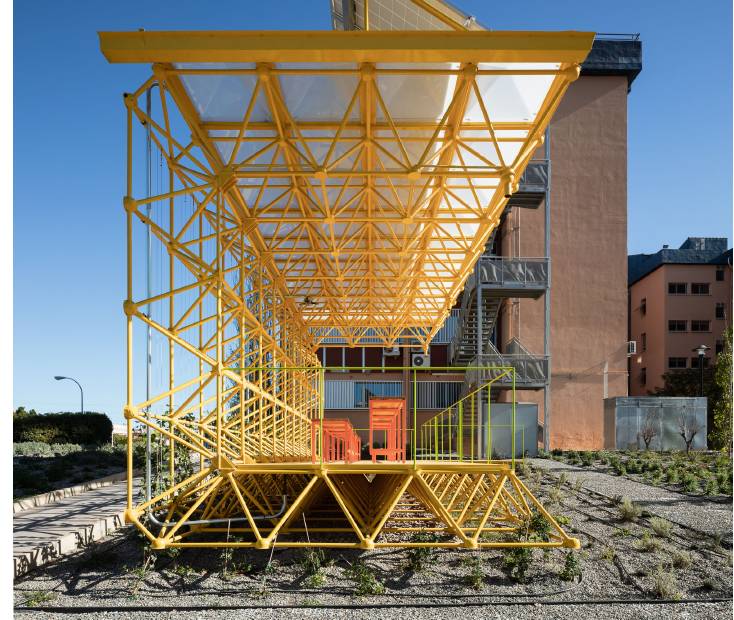
Figure 3. Structural order of the Smart Tree architecture.